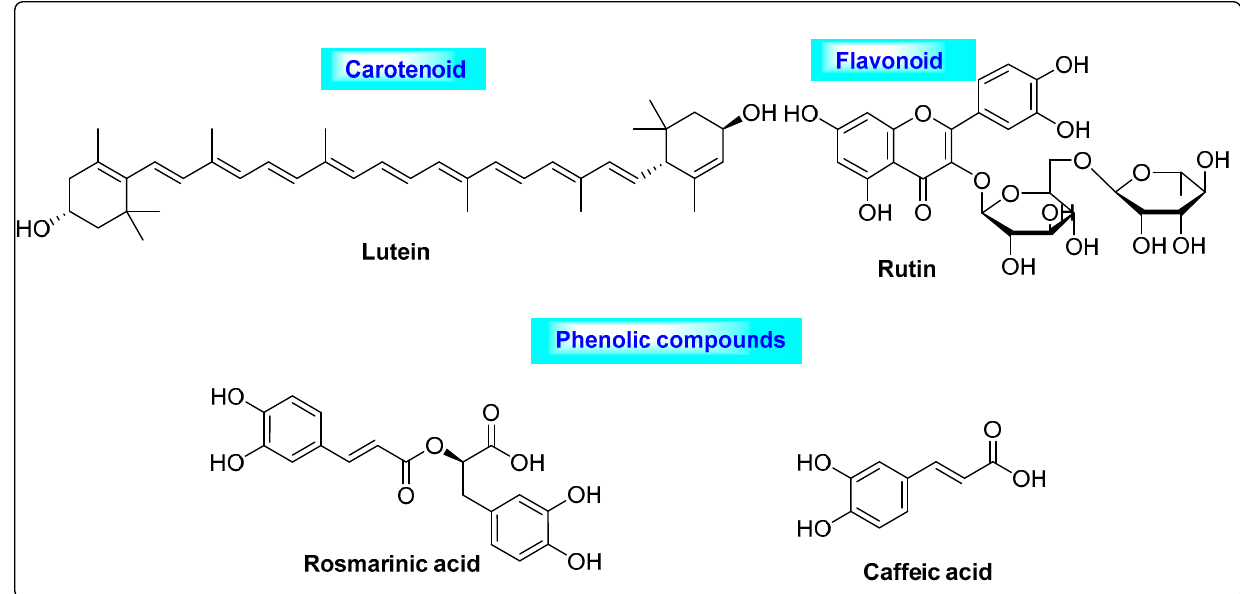
Figure 8. An array of different secondary metabolites of Mentha spicata that possess anti-androgenic activity.